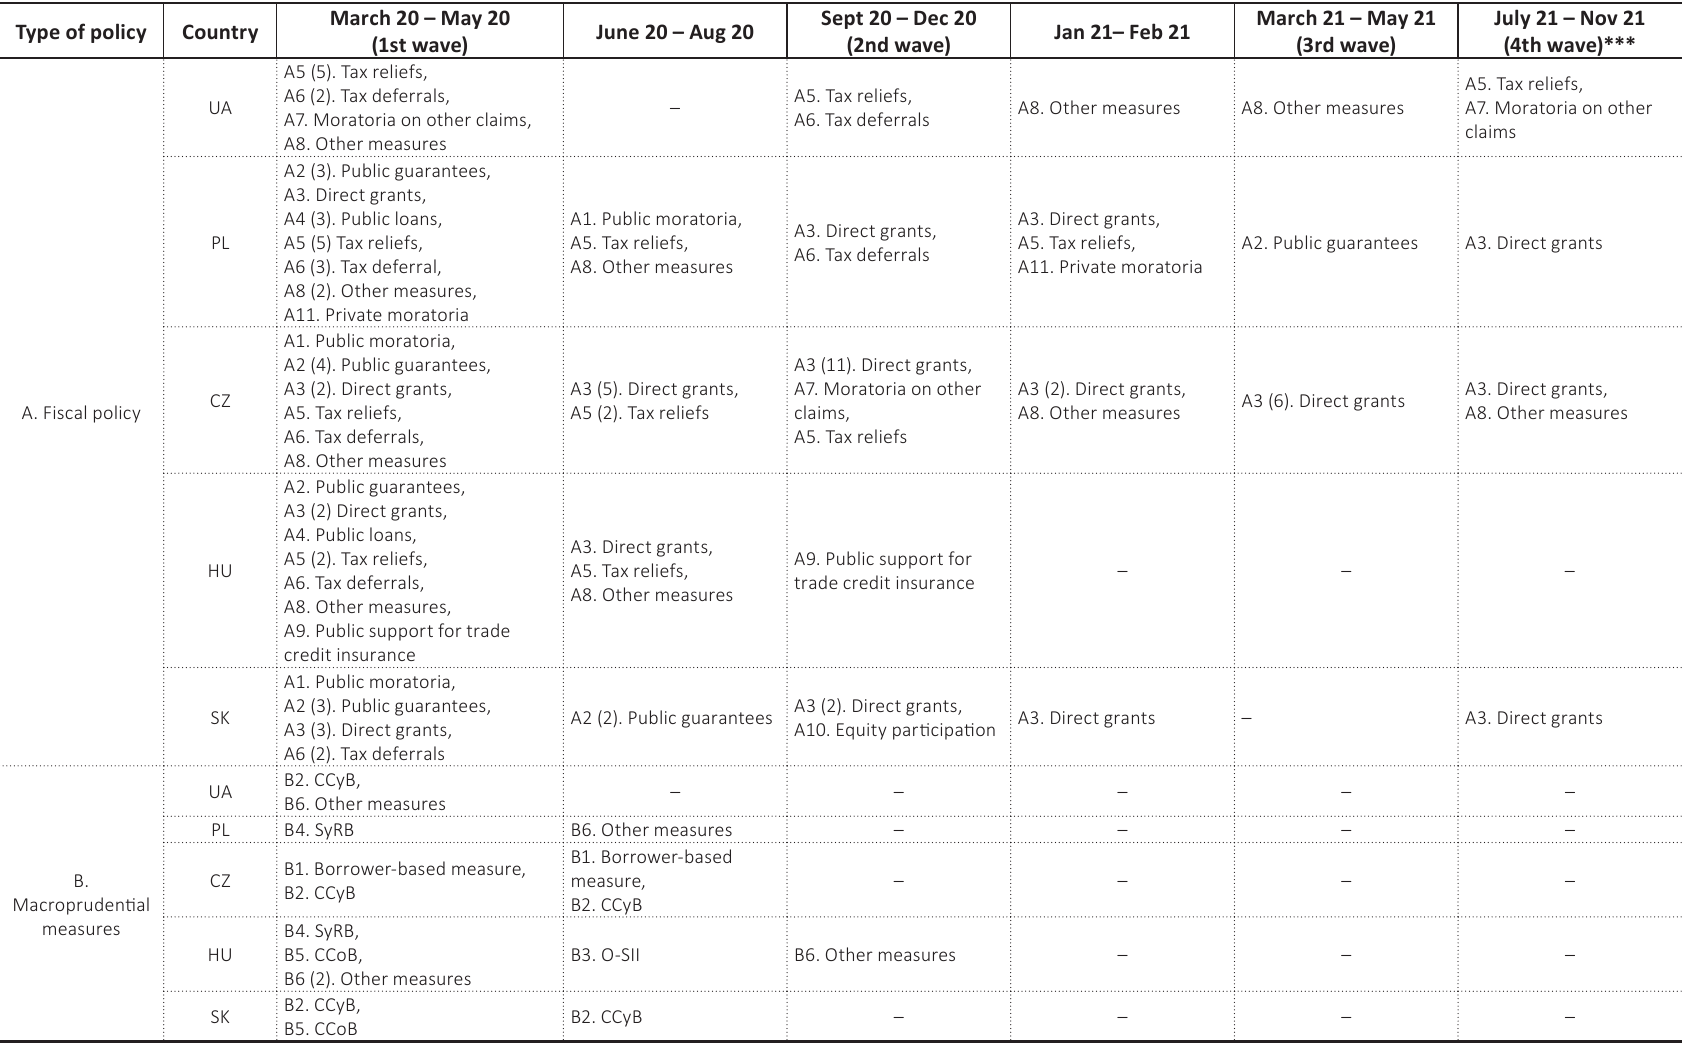
Source: ESRB (2021), IMF